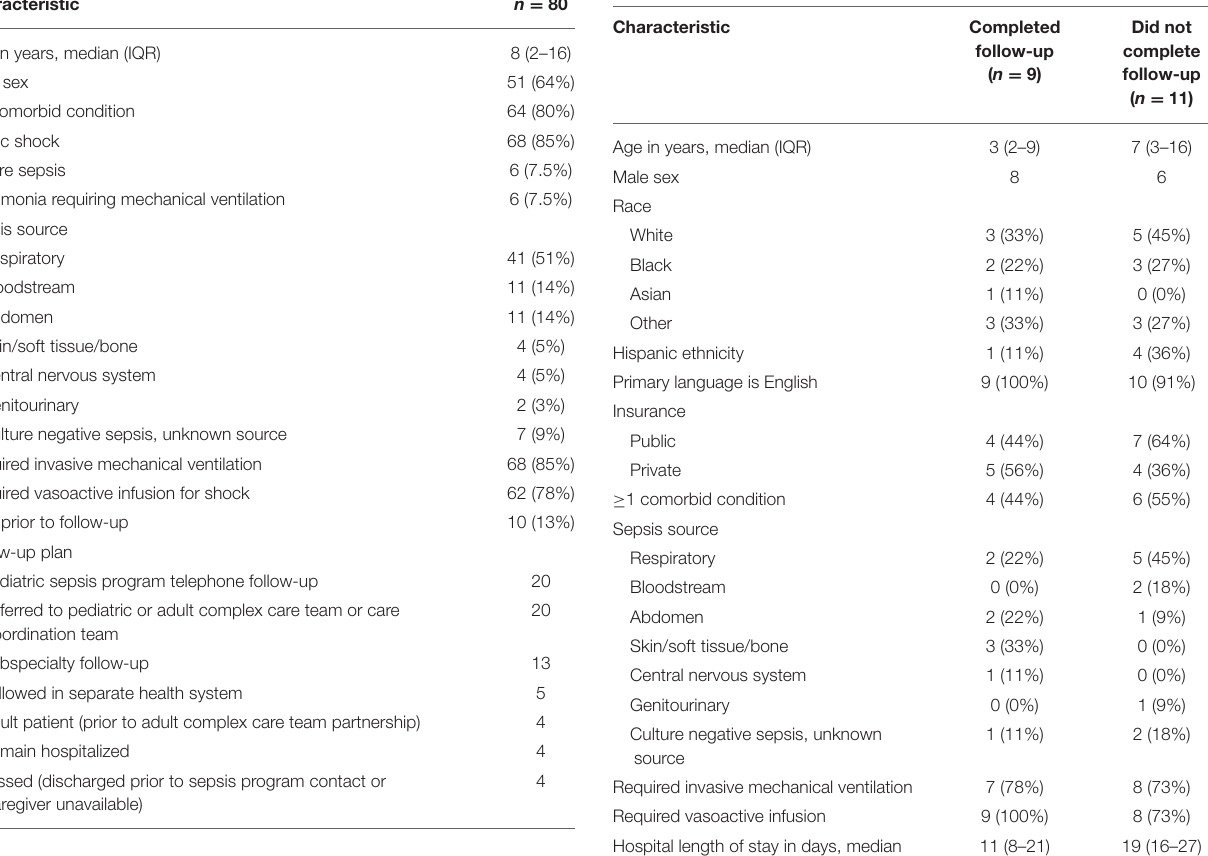
TABLE 2 | Characteristics of patients who did and did not complete Pediatric Sepsis Program telephone follow-up health assessment. Characteristic Completed